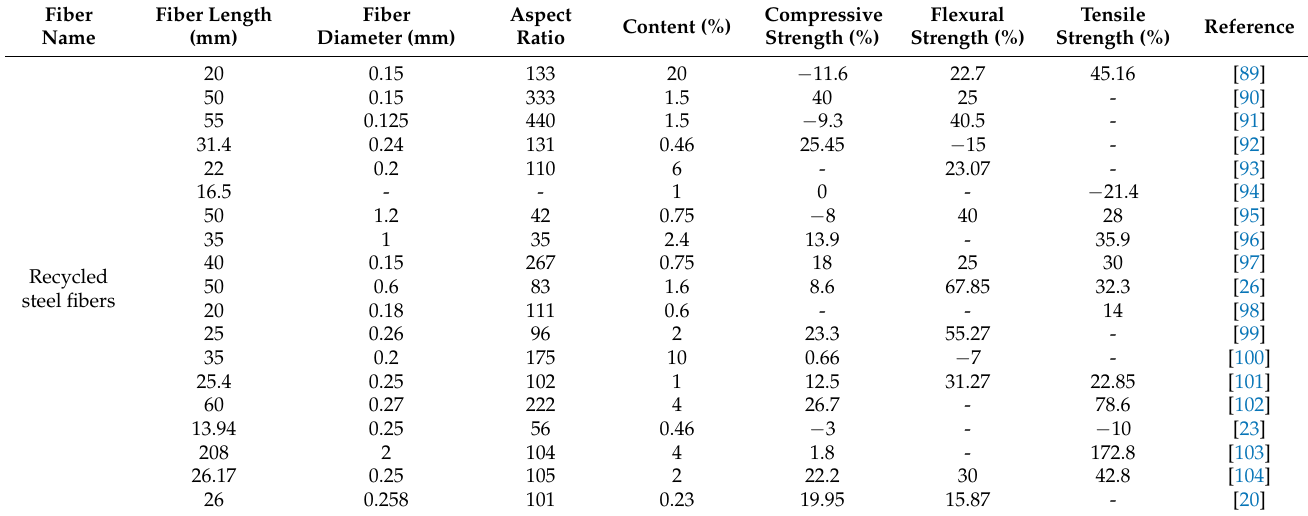
Table 1. Mechanical properties of the different waste recycled steel fiber (WRSF) used in cement-based composites. Fiber